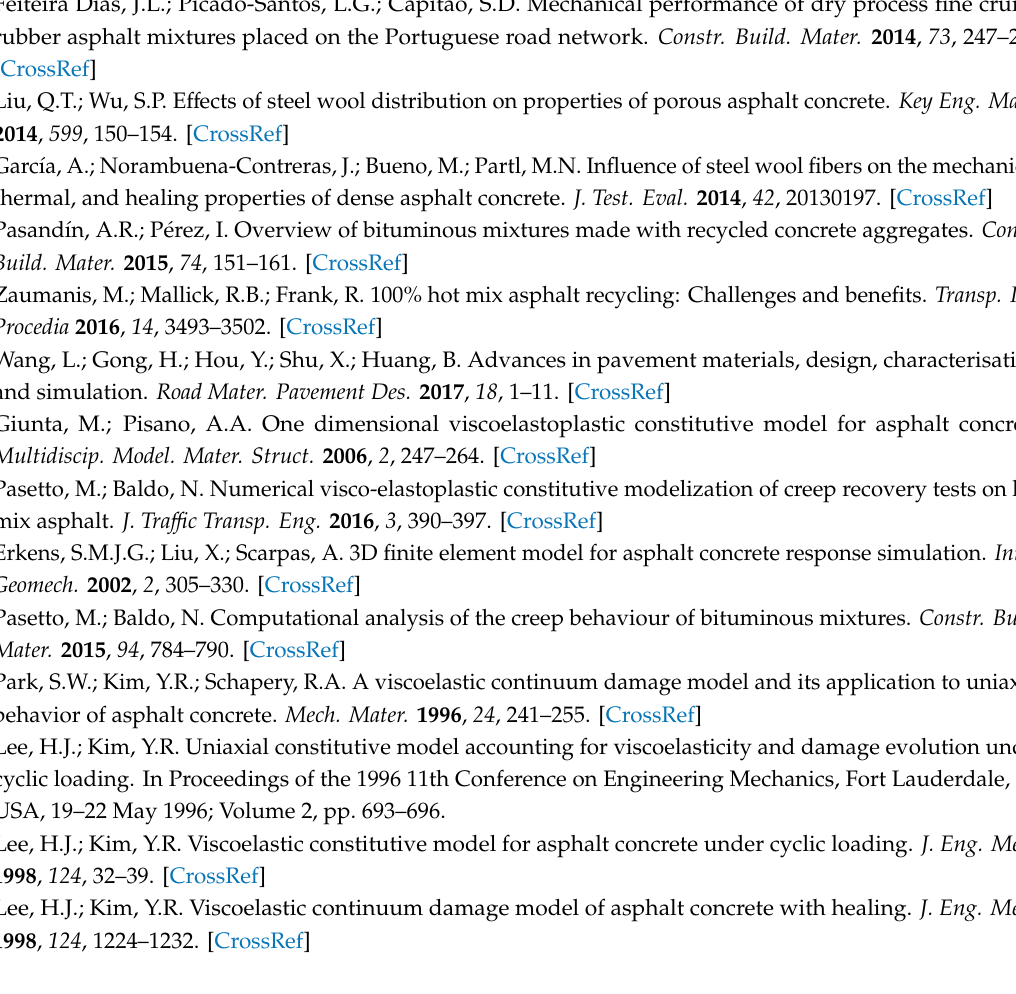
TableS1: Normalizationparametersfortheinputandtargetvariables, TableS2: CharacteristicsofHMA20-50 / 70-Lm specimens, Table S3: Characteristics of HMA20-SBS-Lm specimens, Table S4: Characteristics of HMA20-50 / 70-Db specimens, Table S5: Characteristics of HMA20-SBS-Db specimens, Table S6: Sti ff ness tests results for HMAs with limestone and diabase aggregates, Table S7: Comparison between experimental and ANN predicted data, Table S8: Component of the input weight matrix IW1,1 of the Sti ff ness Modulus final model, Table S9: Component of layers’ weight matrices LW2,1, LW3,2, LW4,3 of the Sti ff ness Modulus final model, Table S10: Component of the hidden layers’ bias vectors b1, b2, b3 and the output layer’s scalar bias b4 of the Sti ff ness Modulus final model, Table S11: Component of the input weight matrix IW1,1 of the Marshall Stability final model, Table S12: Component of layers’ weight matrices LW2,1, LW3,2, LW4,3 of the Marshall Stability final model, Table S13: Component of the hidden layers’ bias vectors b1, b2, b3 and the output layer’s scalar bias b4 of the Marshall Stability final model, Table S14: Component of the input weight matrix IW1,1 of the Marshall Quotient final model, Table S16: Component of the hidden layer’s bias vectors b1 and the output layer’s scalar bias b2 of the Marshall Quotient final